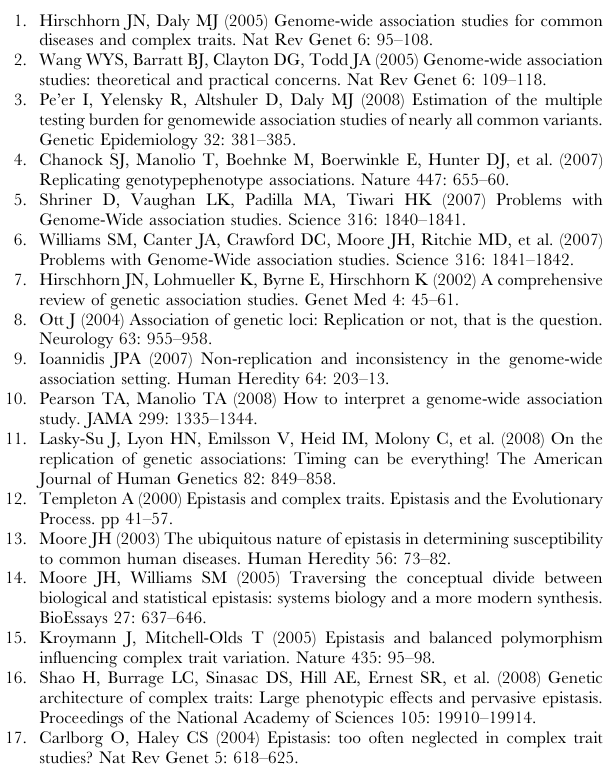
Figure S2 The effect described in Supplementary Figure S2 is consistent across very large to very small heritability models (0.4 to 0.025). In most cases a change in allele frequency of less than 0.1 is enough to reduce the power to replicate a main effect from 80% to 20%. Results shown are for a sample including 400 cases and 400